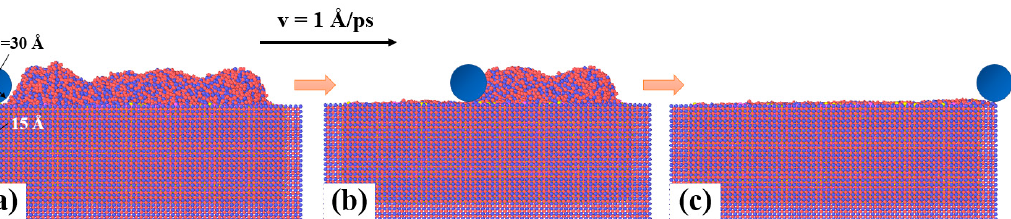
Figure 1. Deposition process: ( a ) preparation of granulated NiTi powder, ( b ) the model of deposition tank, where t 1 and t 2 are the wall thickness, and ( c ) granulated NiTi powder deposition process.